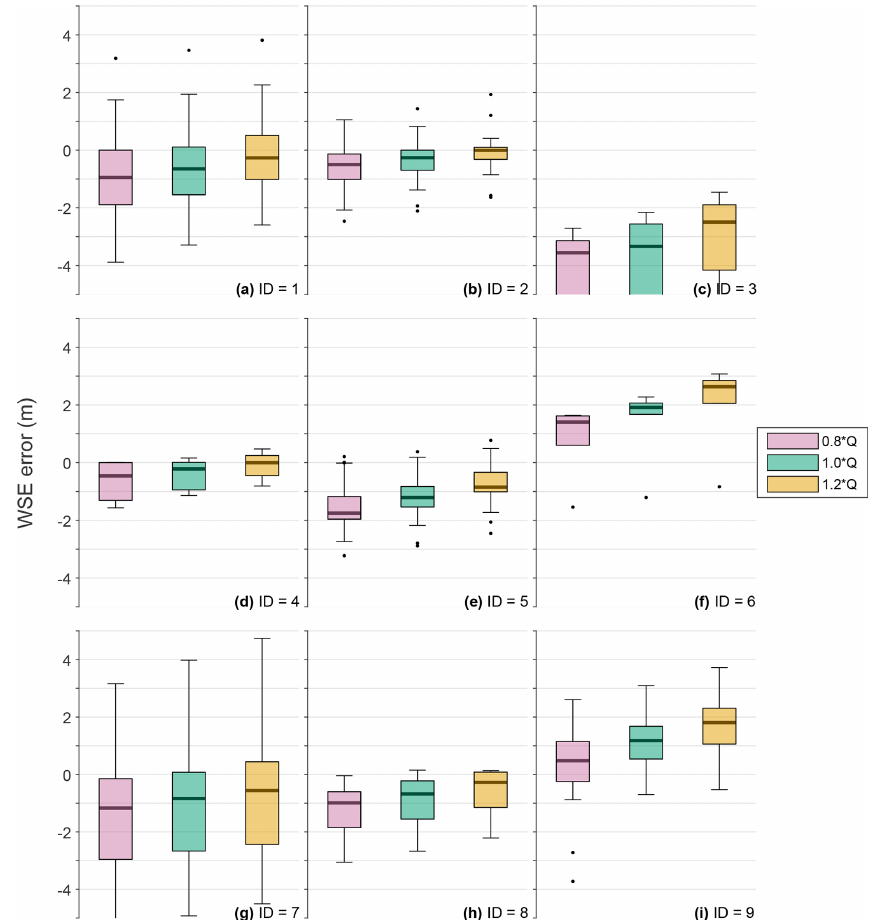
Figure 2. Box plots of water surface elevation errors for each of the nine simulations. The 25th and 75th percentiles bound the shaded boxes with medians within. Whiskers are set to a maximum length of 1 . 5 times the interquartile range beyond the upper or lower quartiles, with outliers shown as black dots. Box shading refers to the following model discharge input: 80% (violet), 100% (green), and 120% (orange) of the gauged discharge.